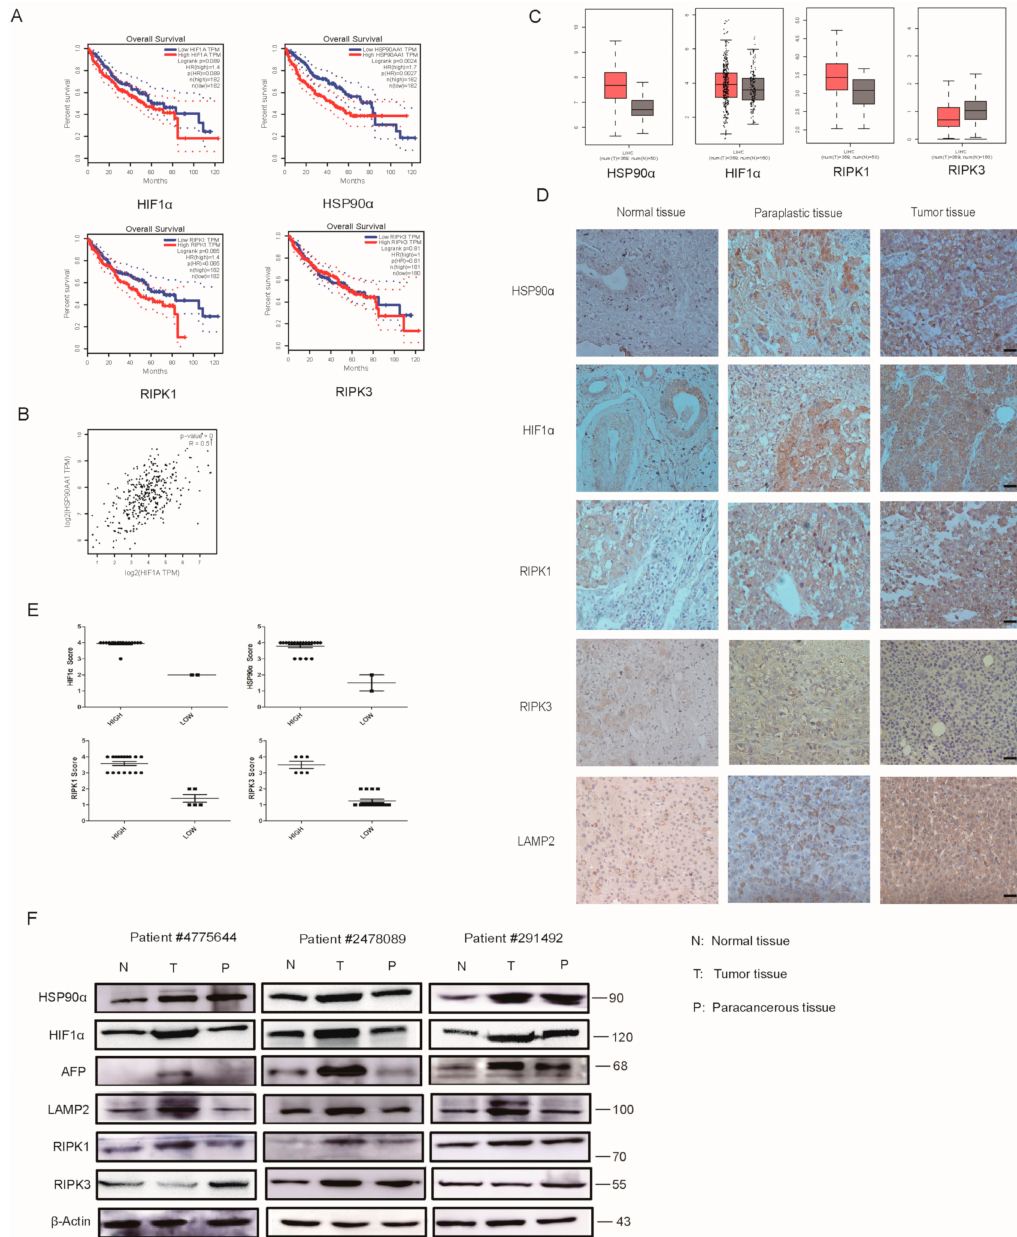
Figure 7. Clinical Analysis of HIF1 α /HSP90 α as a Therapeutic Target. ( A , B ) The overall survival and correlation of several proteins in GEPIA (Gene Expression Profiling Interactive Analysis) database. ( C ) Expressions of HSP90 α , HIF-1 α , RIPK1 and RIPK3 in GEPIA (Gene Expression Profiling Interactive Analysis) database. ( D ) Protein expressions in tumor, para-carcinoma, and normal tissues of patient samples detected by IHC. Scale bar = 500 µ m. ( E ) Analysis the expressions of HSP90 α , HIF-1 α , RIPK1 and RIPK3 in patient samples. ( F ) Protein expressions in tumor, para-carcinoma, and the normal tissues of patient samples detected by